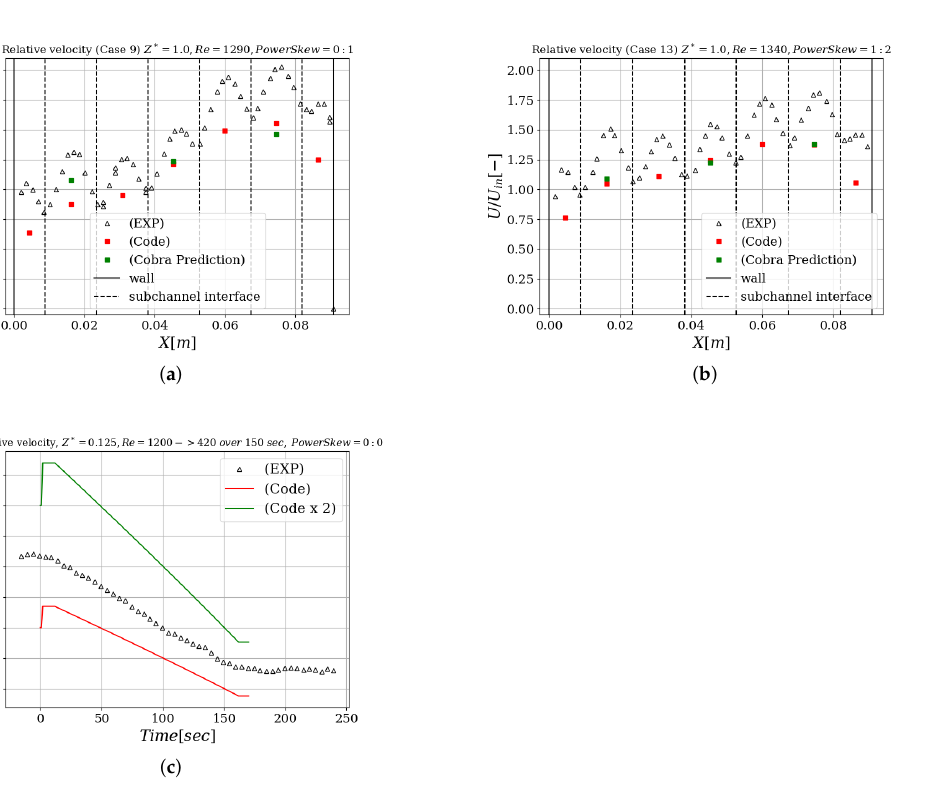
Figure 12. PNL 2 × 6 validation results. ( a ) Case 9 velocity profiles. ( b ) Case 13 velocity profiles. ( c ) Case 5, linear flow transient coast